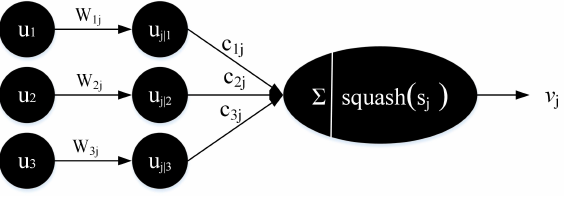
Figure 3. The computation of vector